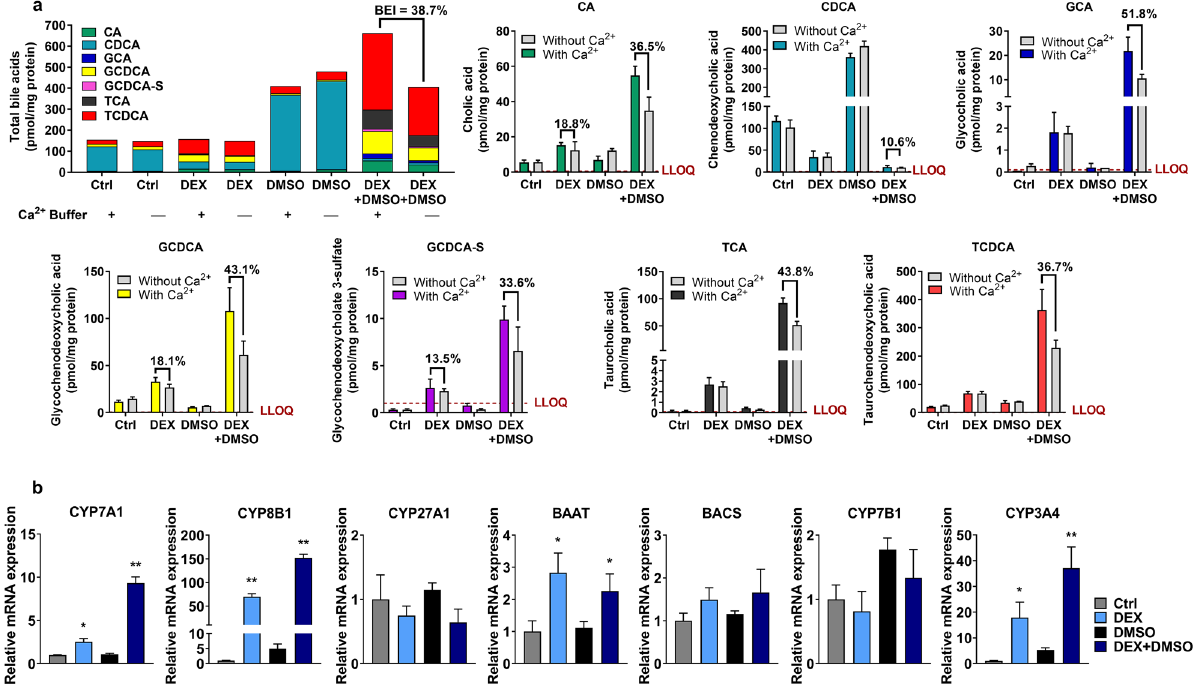
Figure 5. Bile acid profiling and gene expression analysis in HuH-7 cells with overlay. ( a ) Cellular bile acids were measured in overlaid HuH-7 cells cultured for 2 weeks without (Ctrl) and with 1 µM dexamethasone (DEX) and/or 0.5% DMSO using liquid chromatography with tandem mass spectrometry (LC–MS/MS). HuH-7 cells were incubated in standard Hanks’ balanced salt solution (HBSS; With Ca 2+ ) or Ca 2+ -free HBSS buffer (Without Ca 2+ ) for 10 min at 37˚C prior to analysis for determination of “Cells + Bile” and “Cells” content, respectively. Average total bile acid species were plotted based on HuH-7 cell culture conditions. Concentrations of each bile acid species [cholic acid (CA), chenodeoxycholic acid (CDCA), glycocholic acid (GCA), glycochenodeoxycholic acid (GCDCA), GCDCA 3-sulfate (GCDCA-S), taurocholic acid (TCA), and taurochenodeoxycholic acid (TCDCA)] were calculated, normalized to total protein, and plotted as mean ± standard deviation ( n = 3) based on HuH-7 cell culture conditions. In all cases, the biliary excretion index (BEI) was calculated using Eq. (1), and BEI values (%) were included above the relevant data in the graphs, when measurable. The lower limit of quantitation was 0.1 nM for GCA, TCA and TCDCA, 0.5 nM for GCDCA and CA, and 1 nM for CDCA and GCDCA-S. ( b ) mRNA was measured by RT-qPCR in HuH-7 cells cultured for 2 weeks with overlay, 1 µM DEX and/or 0.5% DMSO. Threshold cycle (C T ) values of each gene of interest [ cytochrome P450 ( CYP) 7A1 , CYP8B1 , CYP27A1, bile acid-CoA: amino acid N-acyltransferase (BAAT), bile acid-CoA synthase (BACS), CYP7B1, and CYP3A4 ] were normalized to the housekeeping gene β-actin ( ACTB ) and compared with control (Ctrl; set to 1.0). Data are plotted as mean ± standard deviation (n =